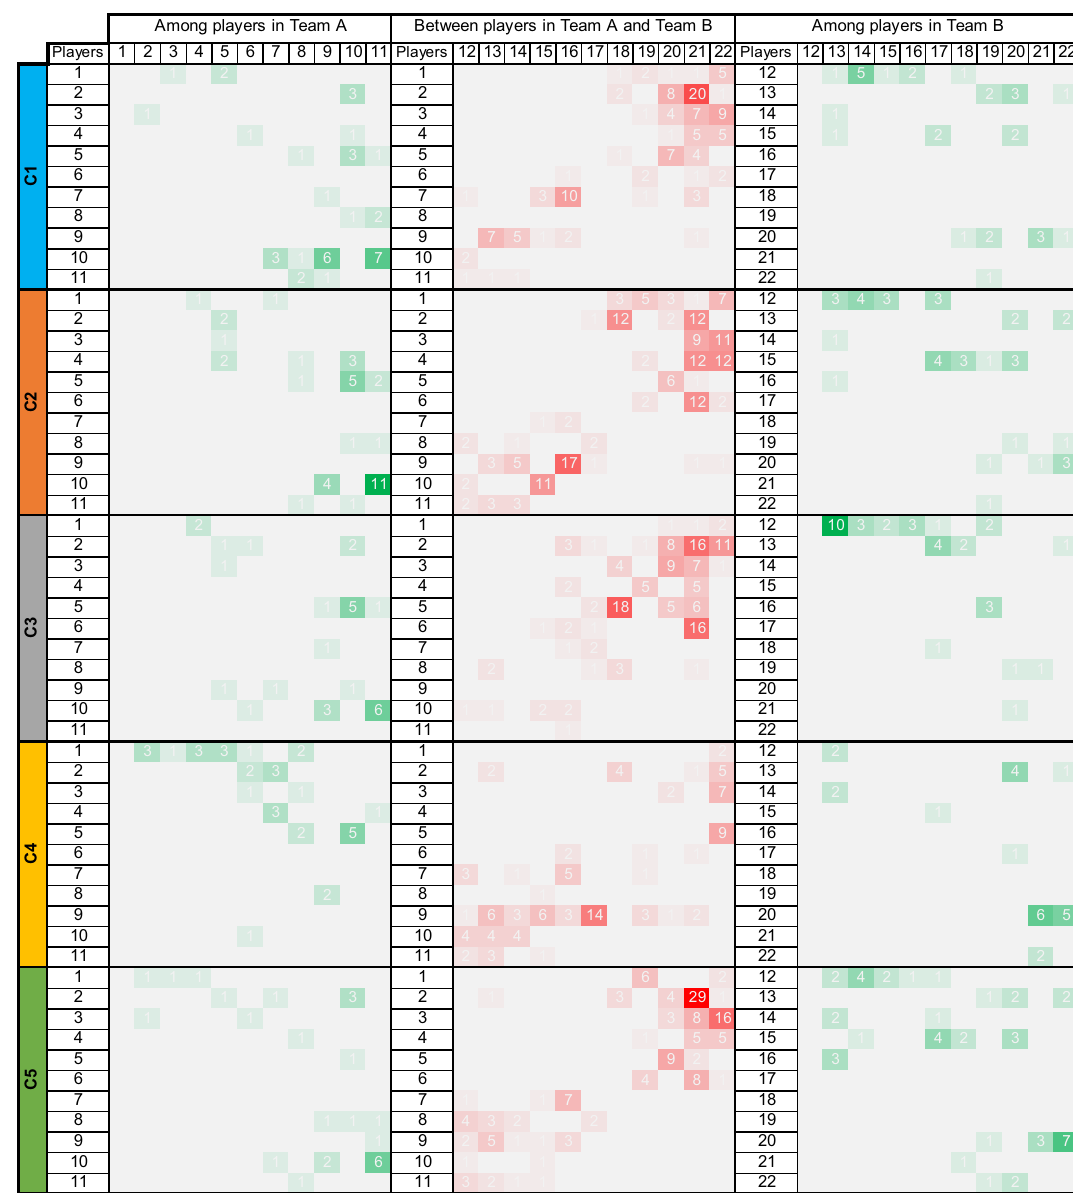
Figure 9. Changing the ball possession among players and between teams. The green colour indicates successful passes among teammates. These values should be read from Player on the row to Player in the column. The red cells show the accumulated number of successful attempts to get the ball (interceptions, retrieves, tackles, etc.) that has caused changing the ball possession between teams, without specifying from and to which two involved players. The configurations are as follows: default (C1), zero energy consumption (C2), changed formation for Team B (C3), changed formation for Team A (C4), and alternative marking strategies